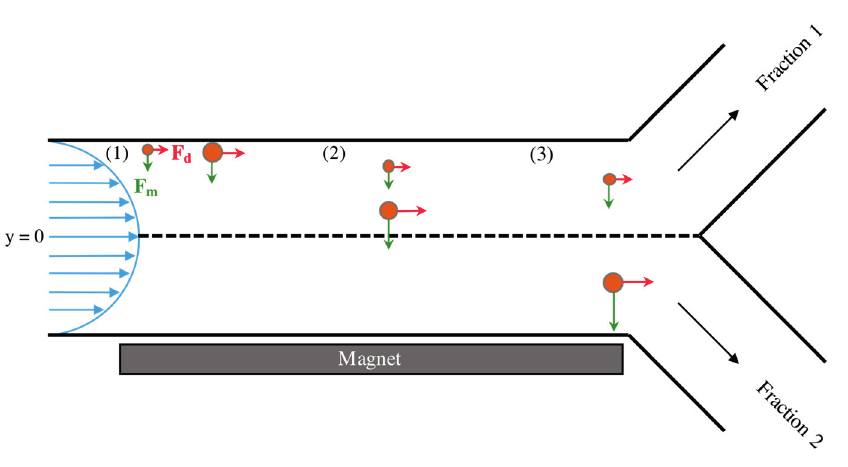
Figure 1. Illustration of the proposed experimental setup and the force balances experienced by two differently sized magnetic nanoparticles as they flow through the system. Green arrows represent the magnetic force ( F M ) and red arrows represent the drag force ( F D